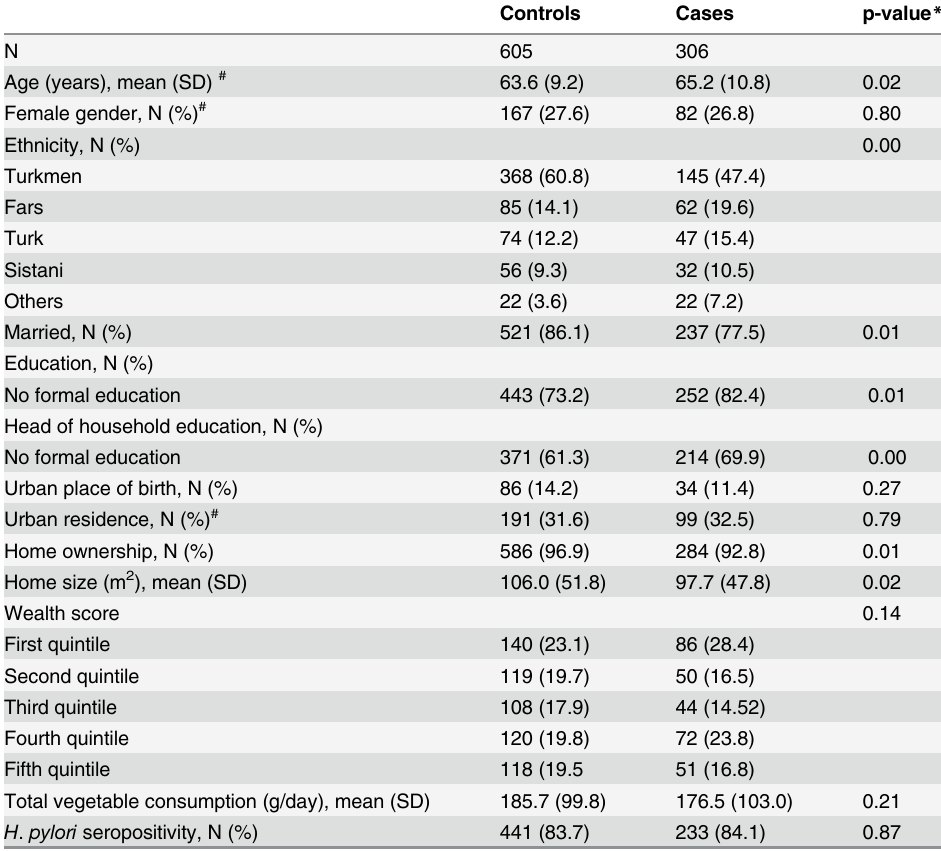
Table 1. Characteristics of 306 cases and 605 controls in the Golestan Gastric Cancer Case-Control Study.